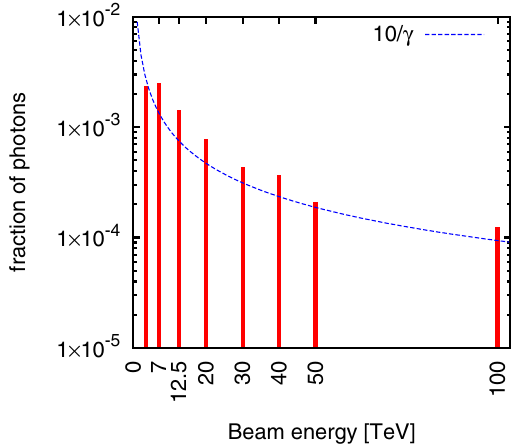
FIG. 11. Fraction of photons absorbed by an FCC-hh-type chamber as a function of the beam energy for a normalized emittance of ε ¼ 2 . 5 μ m and the LHC optics.